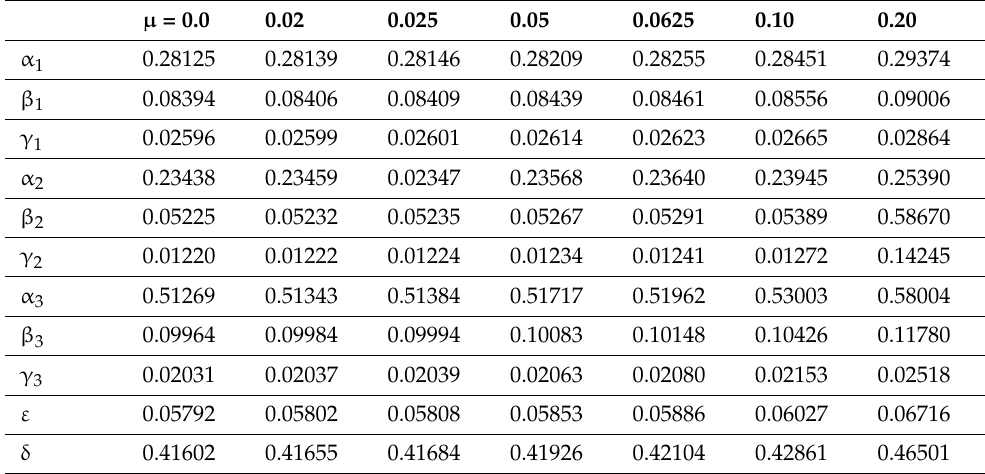
Table 3. Polarizabilities and hyperpolarizabilities for the helium ion for various values of µ . µ =